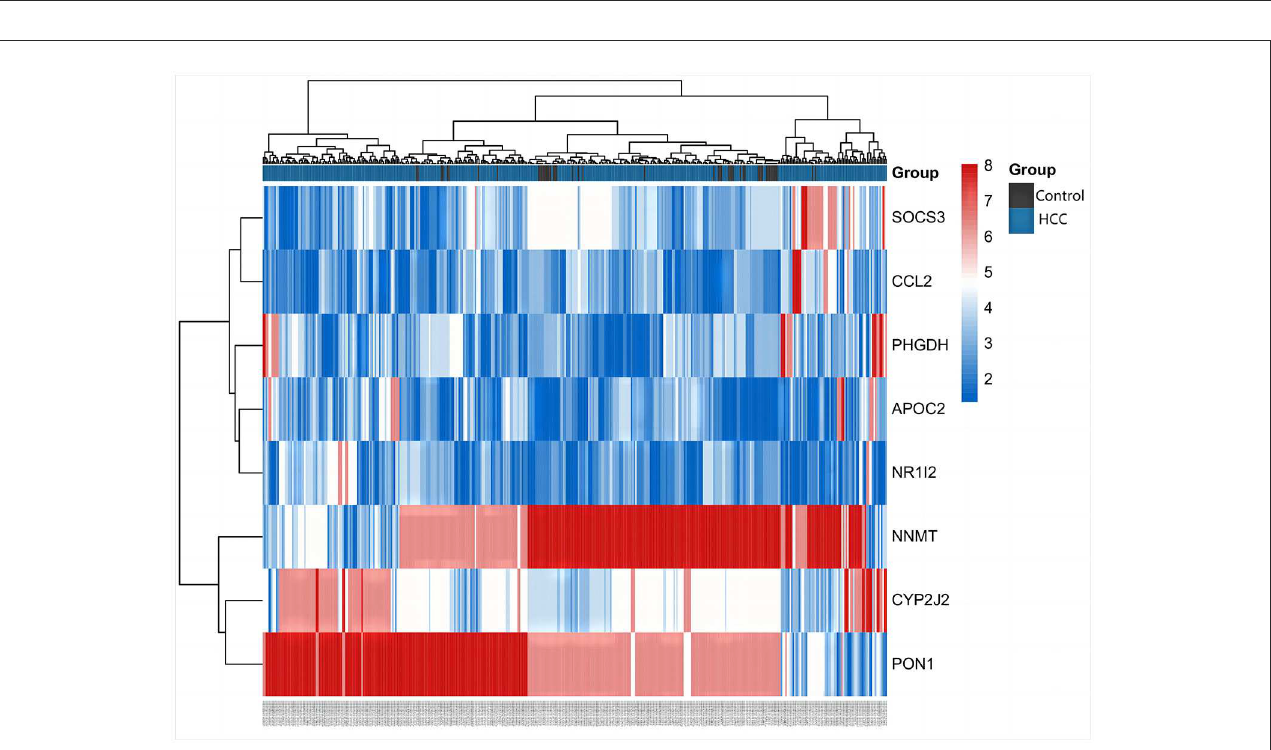
FIGURE4 Clustering of metabolism-related genes in